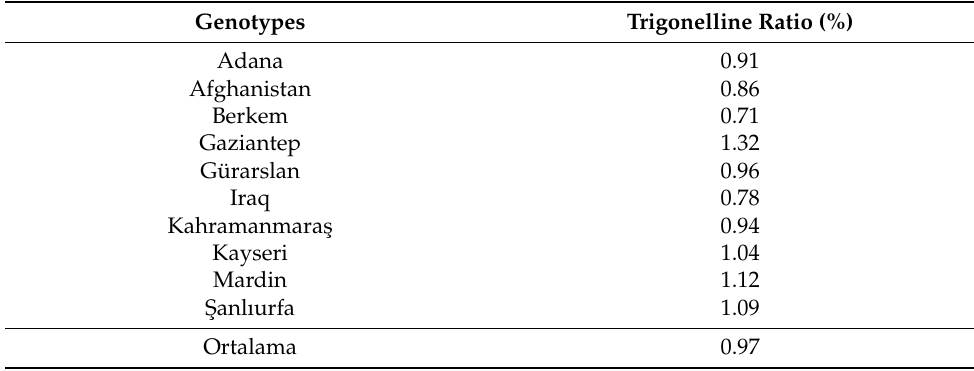
Table 9. Trigonelline ratio of fenugreek